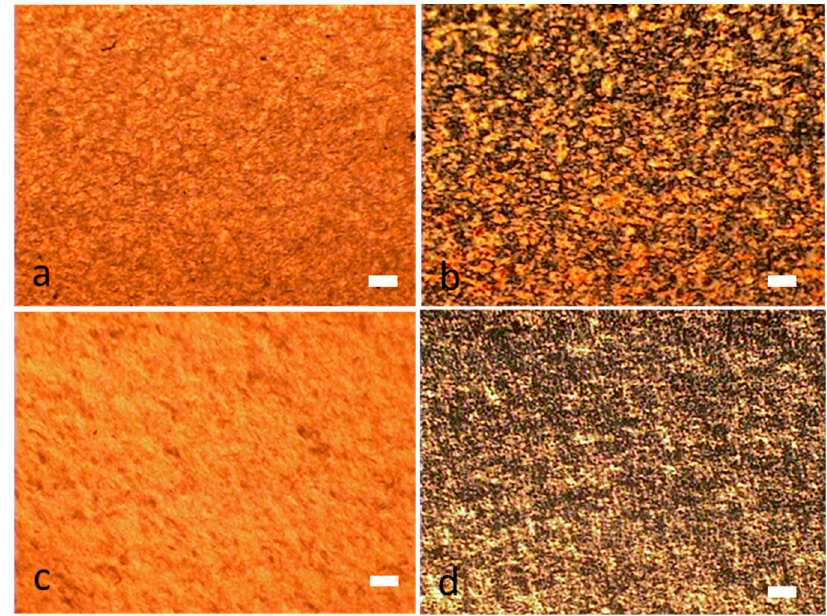
Figure 7. Optical microscope images of 2% SWNT and 98% CNC hybrid films. ( a , c ) Normal light optical microscope images of ( a ) sedated dried and ( c ) blade-coated hybrid films. ( b , d ) Polarized light optical microscope images of ( b ) sedated dried and ( d ) blade-coated hybrid films. Scale bar: 20 μ m.